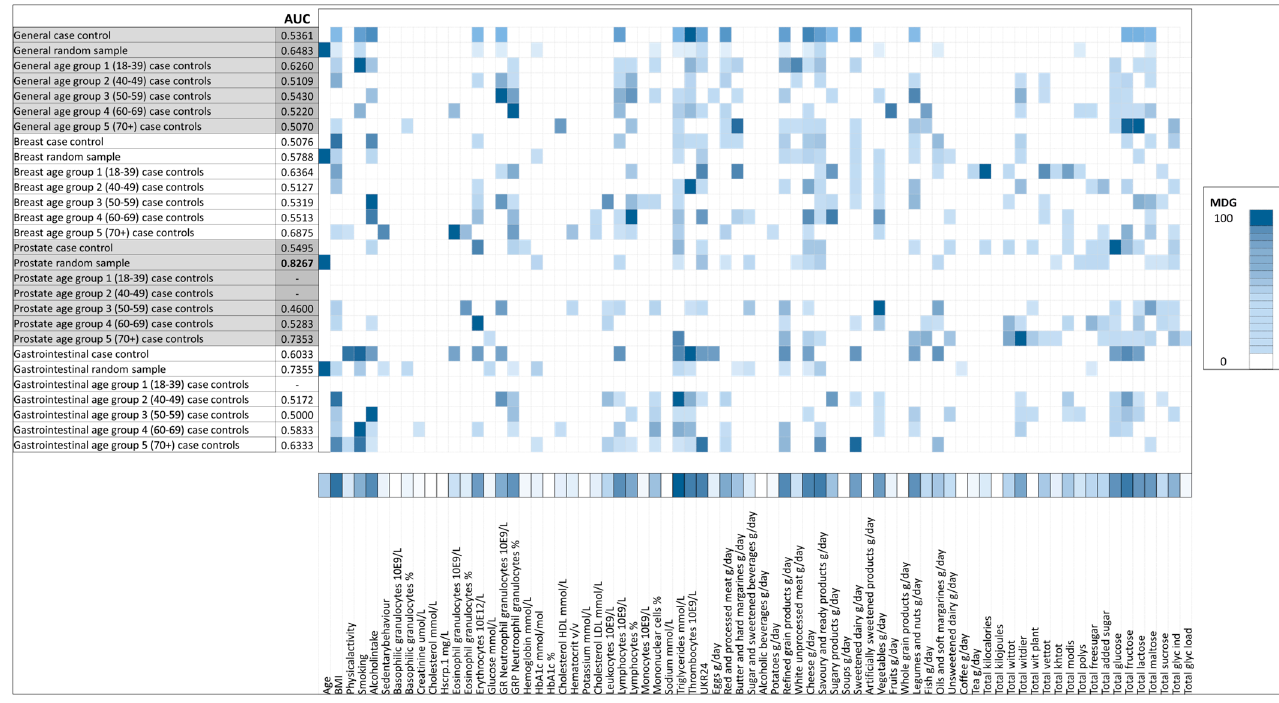
Figure 2. Area under the receiver operator curve (AUC), for random forest models and the most important variables for classification based on the Gini index (MDG).